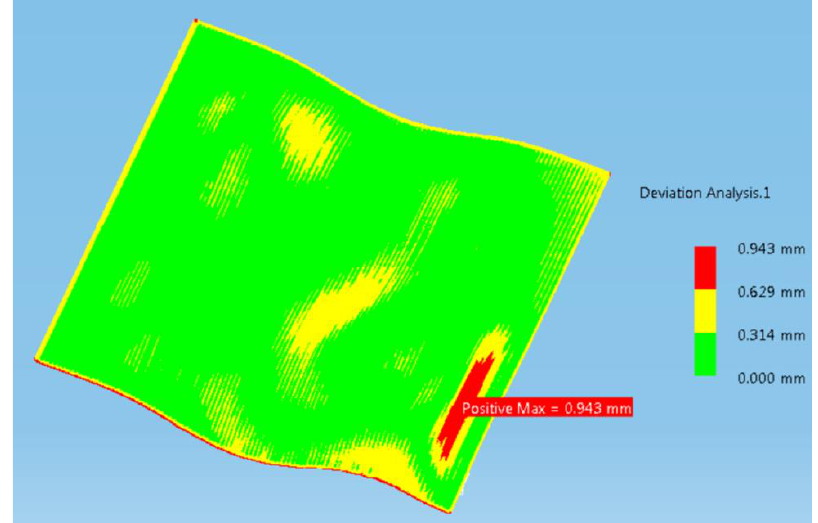
Figure 11. Comparative analysis result between generated surface and the measured surface with contact 3D scanning (ordered point cloud).